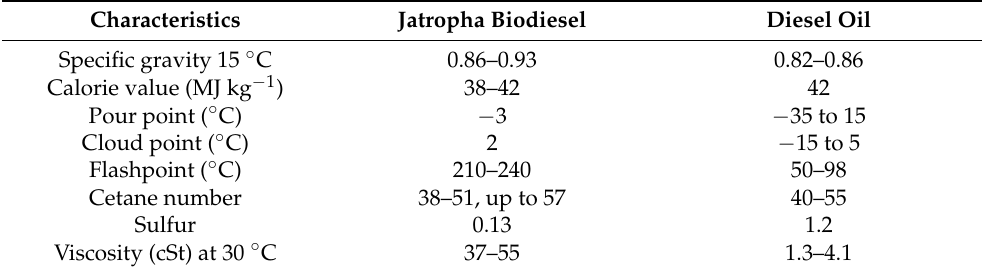
Table 6. Fuel characteristics of Jatropha biodiesel vs. diesel oil